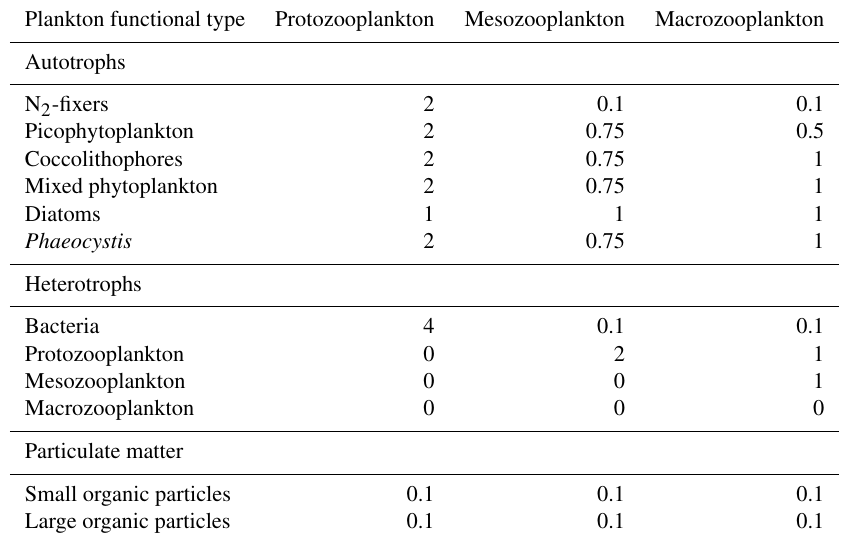
Table 3. Relative preference of zooplankton for food. The preferences are weighted with the biomass to obtain the model parameter value as in Buitenhuis et al.